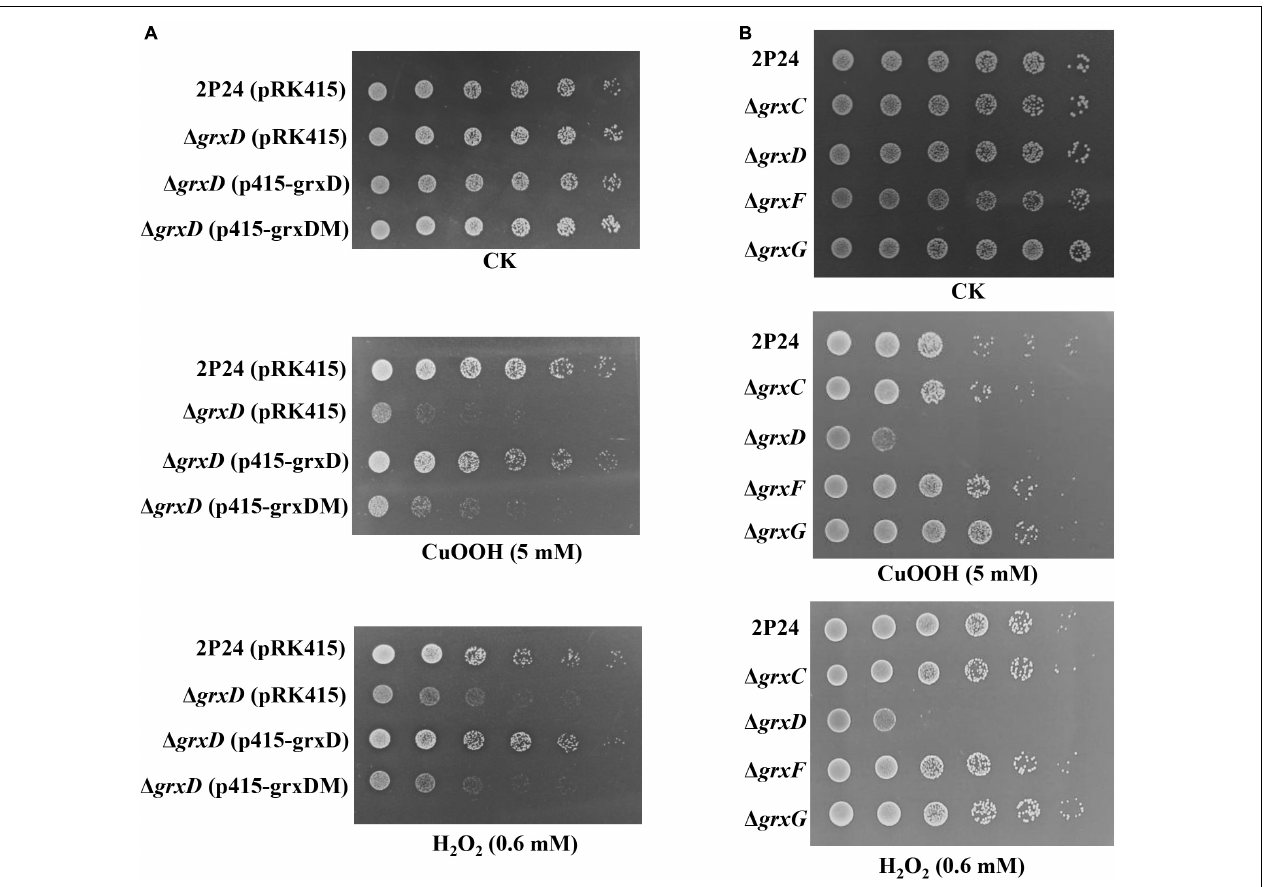
FIGURE 5 | Effect of the grx mutants on tolerance of Pseudomonas fluorescens to peroxides. Pseudomonas fluorescens 2P24 (pRK415), the grxD mutant (pRK415), the grxD mutant (p415-grxD), and the grxD mutant (p415-grxDM) (A) , or 2P24, the grxC mutant, the grxD mutant, the grxF mutant, and the grxG mutant (B) were grown in Lysogeny Broth (LB) broth, serially diluted and spotted onto ABM plates or ABM plates containing 5 mM CuOOH or 0.6 mM H 2 O 2 . Plates were incubated at 28 ◦ C for 2